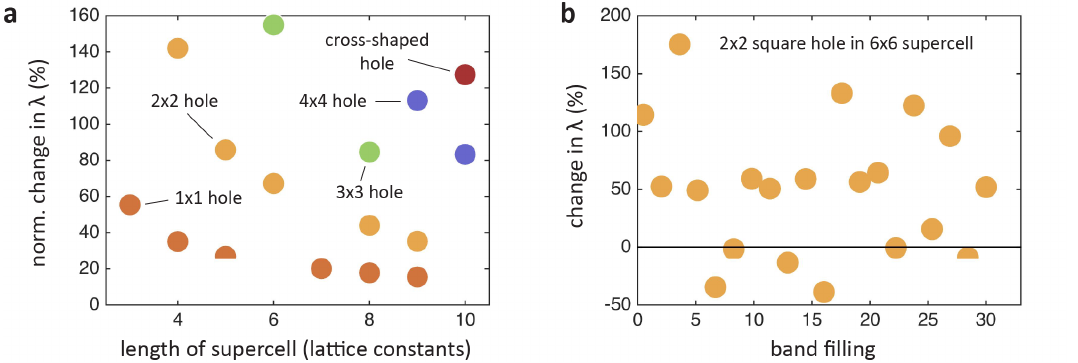
Figure 4: Enhancement of λ and T . a , Dependence of the coupling constant λ on the supercell c size L and shape, normalized by the change in N ( 0 ) (see Appendix for details). The labels are for all markers with the same color. All values are relative to the pristine material and normalized for density of states effects. The filling in both pristine and meta-superconductor is 0.5% for all supercell sizes, to ensure that we are below the first band gap and thus concentrate on the kinematic constraints. b Dependence of the coupling constant λ on the filling. Here, the resulting change is a combination of density of states effects and kinematic